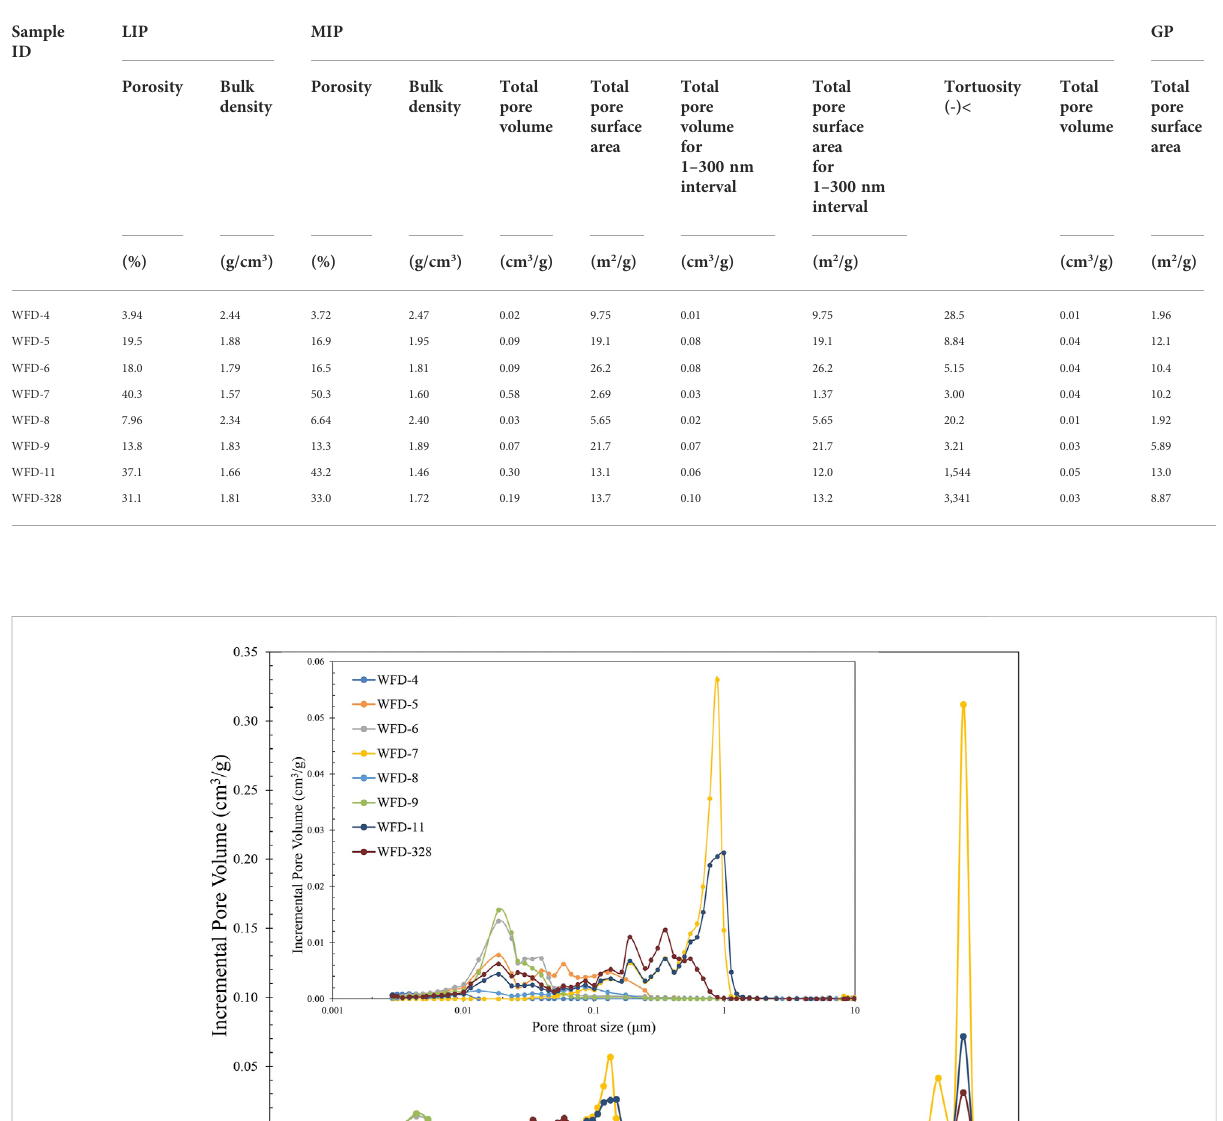
Frontiers in Earth